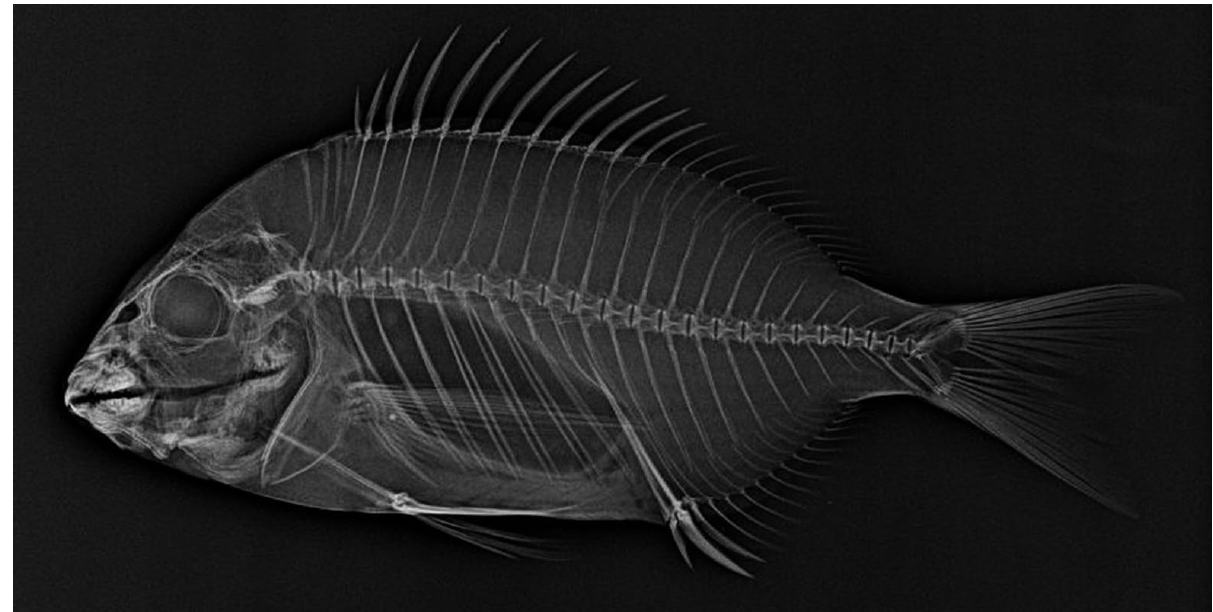
Fig. 4. – Diplodus levantinus n. sp., HUJ 20535, holotype, 184.1 mm SL, off Jaffa, Israel, 30 Oct. 2015. Lateral view; x-ray (Photograph: I.